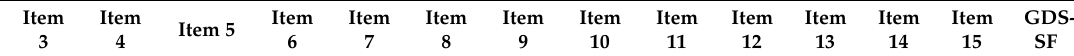
Table 3. Results of the GDS-SF inter-item correlations (n =